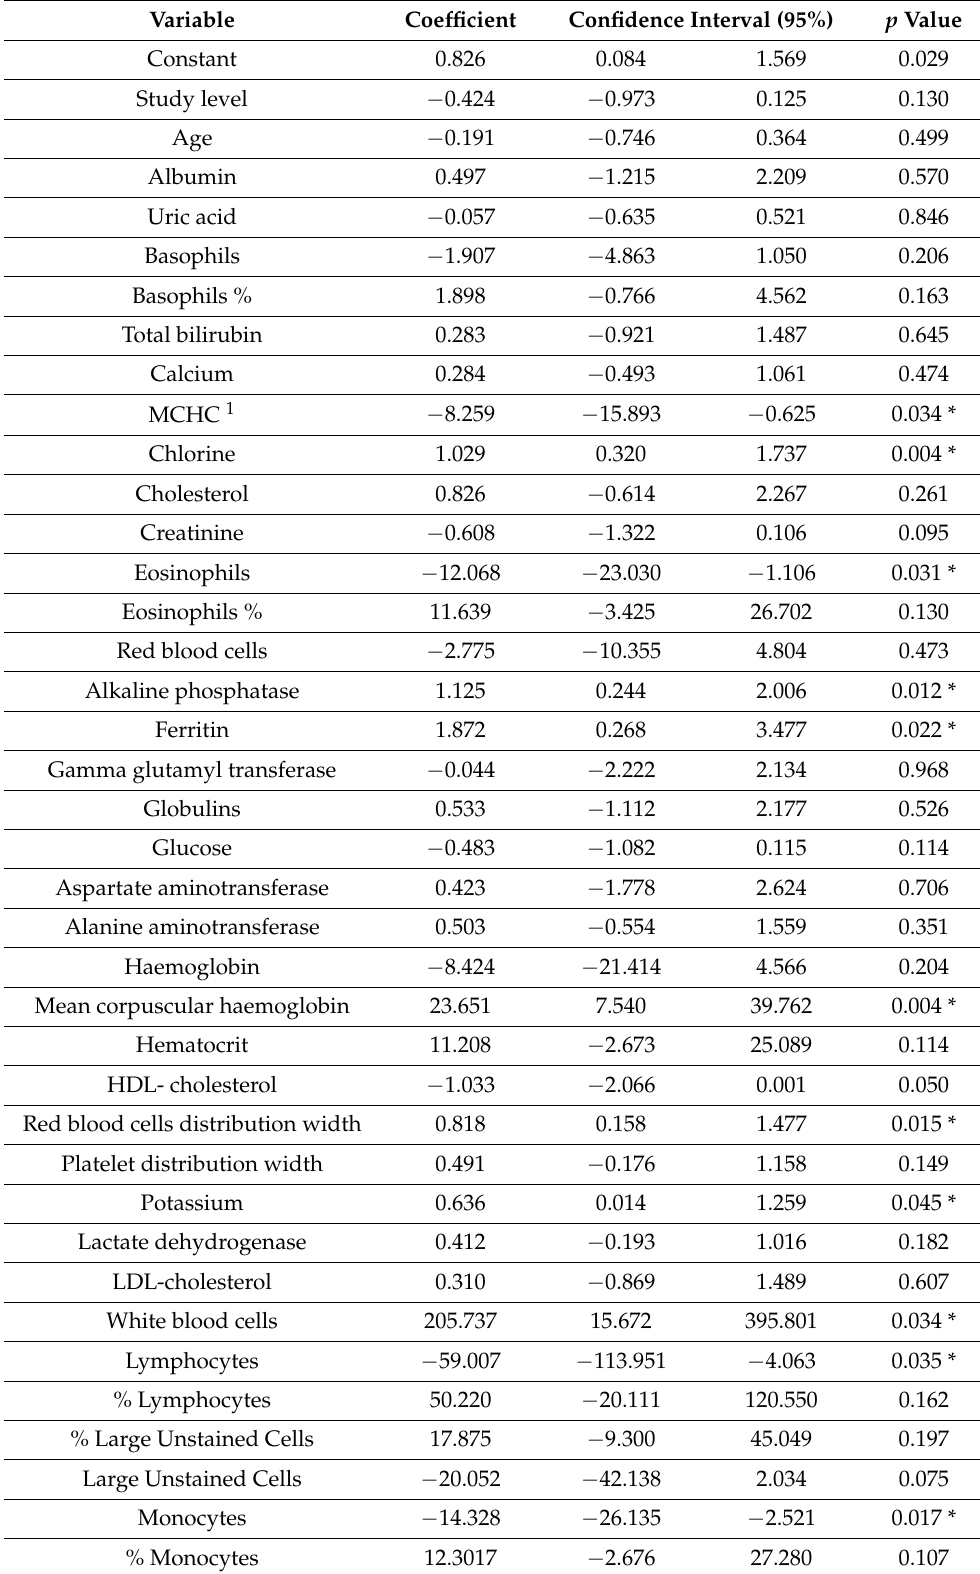
Table 1. Coefficients calculated in logistic regression, for all the variables used, together with the confidence interval and its p -value. Statistically significant ones are marked with